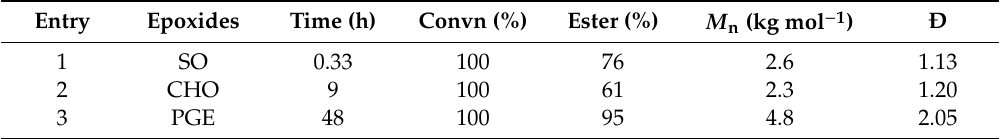
Table 2. ROCOP of MA with di ff erent Epoxides [a] .